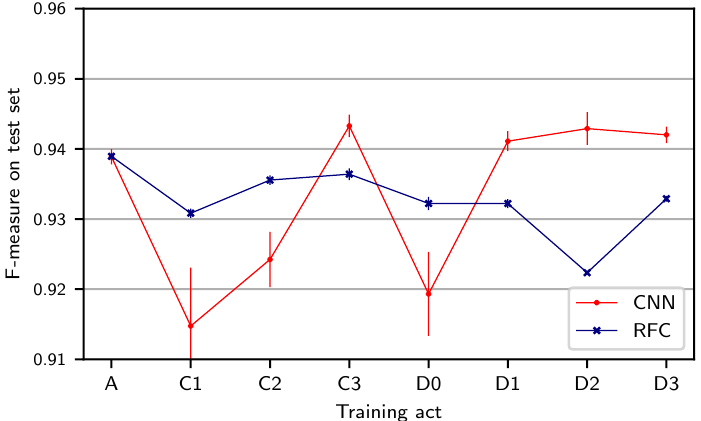
Figure 6. Results for both systems when training on different (individual) acts from the test version ( opera split